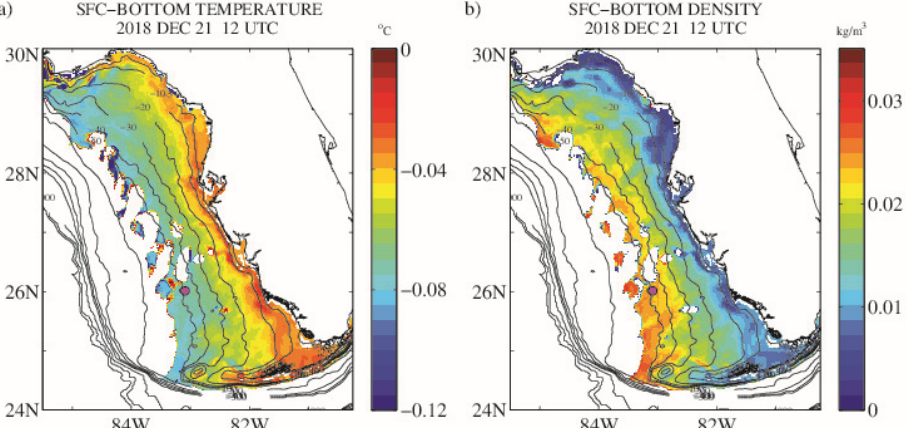
Figure 8. ( A ) COAMPS temperature results (surface–bottom) for 21 December 1200 UTC, where Figure 8. ( a ) COAMPS temperature results (surface–bottom) for 21 December 1200 UTC, where negative values (blue) indicate temperature inversions and ( B ) surface density ( σ t ) minus bottom negative values (blue) indicate temperature inversions and ( b ) surface density ( σ t ) minus bottom density, where only positive values (inversions) are shown on the scale. density, where only positive values (inversions) are shown on the